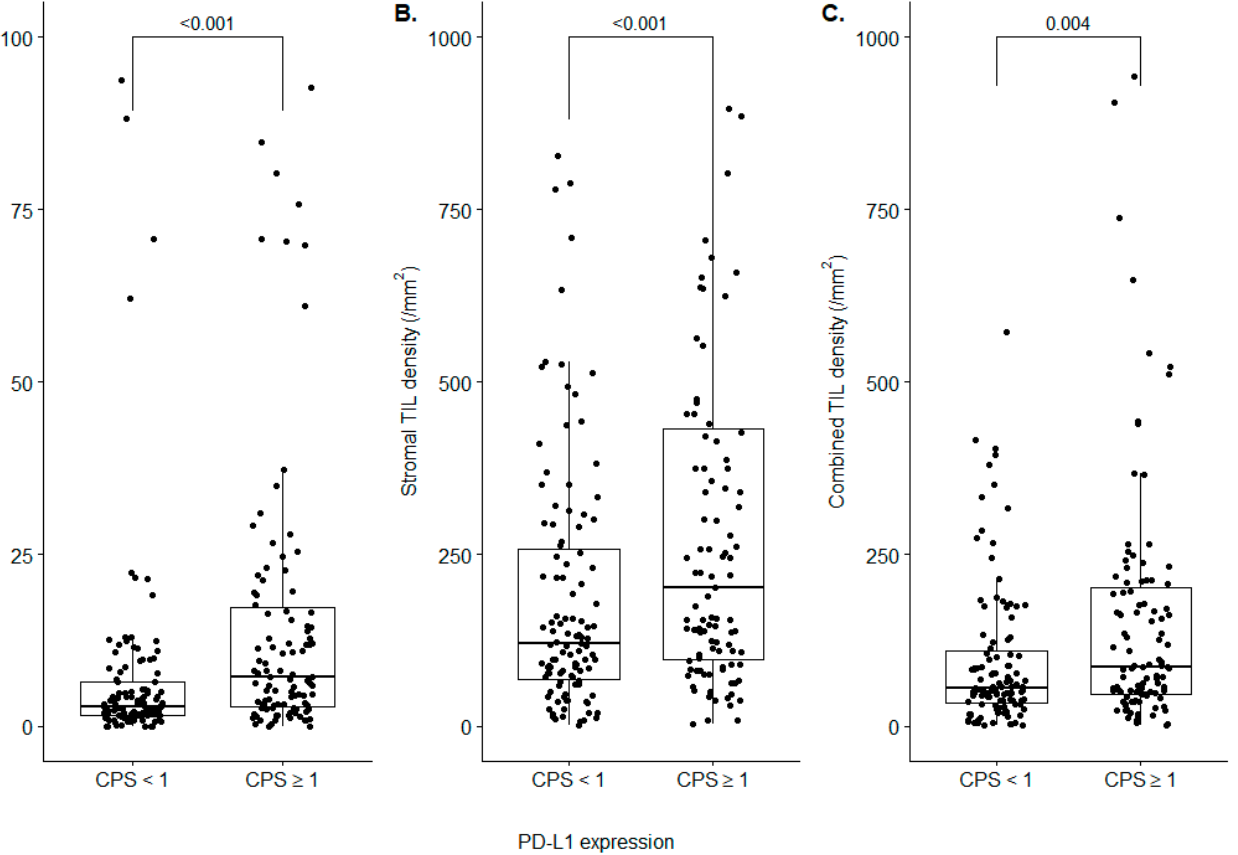
Figure 3. Analysis of the TIL densities in PD-L1 CPS subgroups. ( A ) Intra-tumoral TIL density; ( B ) stromal TIL density; ( C ) combined TIL density. A significant positive association between the log values of the PD-L1 CPS and intra- tumoral TIL density was observed (Pearson’s coefficient ( r ) = 0.37, p < 0.001) (Figure 4A). The positive correlations were also identified between the log value of PD-L1 CPS and both stromal TIL and combined TIL, although the correlation coefficient and degree of significance were smaller than intra-tumoral TIL ( r = 0.24, p = 0.002) (Figure 4B,C). The ex- amination of PD-L1 IHC images revealed that PD-L1-positive lymphocytes were distributed both intratumorally and